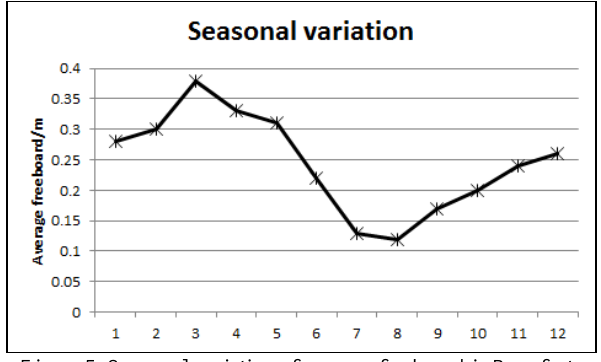
Figure 5. Seasonal variation of average freeboard in Beaufort